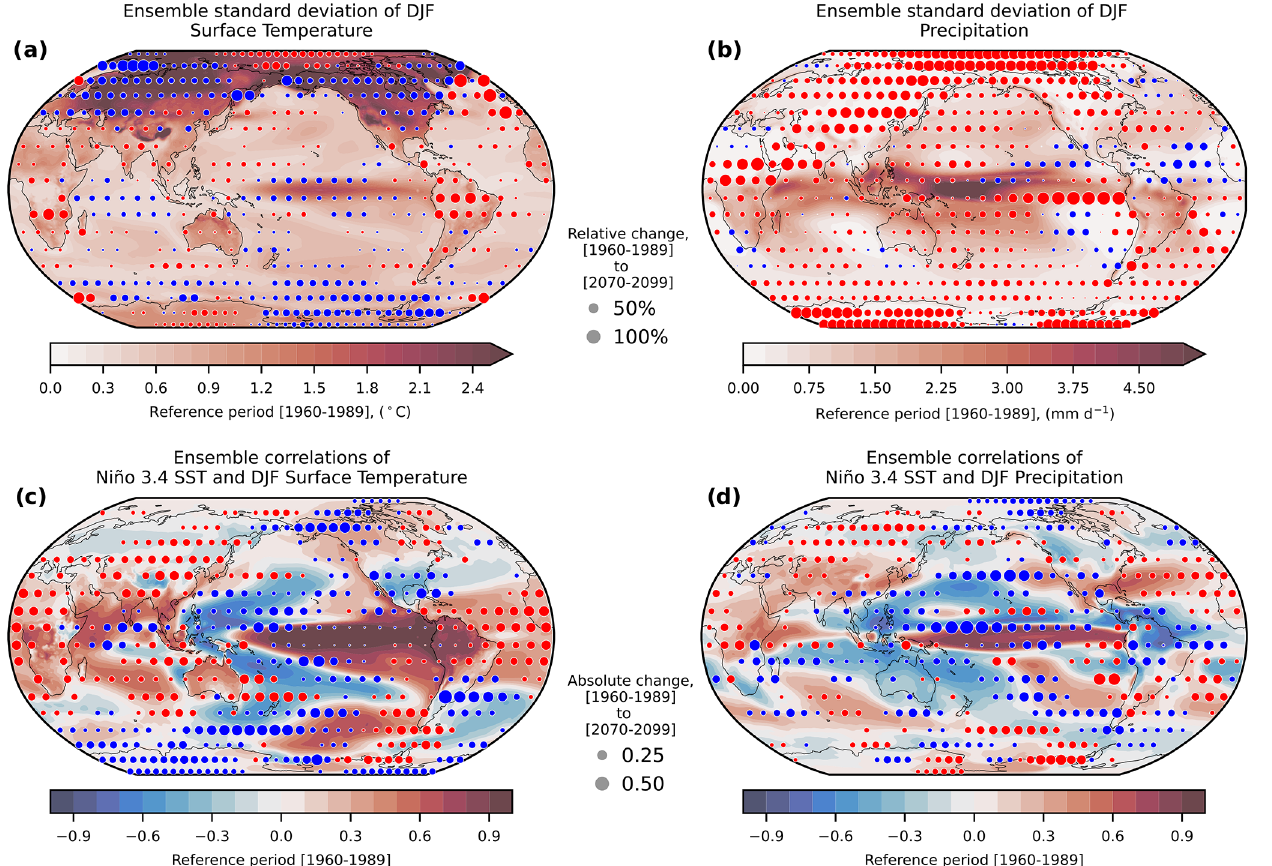
Figure 4. Changes in the patterns of interannual variability and Niño 3.4 correlation coefficients of December–January–February (DJF) surface temperature and precipitation. In the top row the color shading shows the time-averaged across-ensemble SD of the DJF seasonal mean surface temperature (a) and precipitation (b) for the period 1960–1989. Circles show the relative changes in the SD between 2070–2099 and 1960–1989, where insignificant change ( p ≥ 0 . 05) has been removed. Statistical significance of the changes (circles) was determined based on the p values of the two-sample Welch’s t tests for the equality of temporal means of the SDs, with the equivalent sample sizes adjusted to account for serial correlations (Sect. 3.3). In the bottom row the color shading shows ensemble-wise correlations of the Niño 3.4 index with surface temperature (c) and precipitation (d) anomalies for DJF, averaged over the period 1960–1989. Circles show the absolute change in correlations between 2070–2099 and 1960–1989, where statistically insignificant changes ( p ≥ 0 . 05) have been removed. The Niño 3.4 index for ENSO is the spatial average of sea surface temperature within 5 ◦ S–5 ◦ N, 170 ◦ –120 ◦ W. Statistical significance of the changes (circles) was determined based on the p values of two-sample Student’s t test of the Fisher z -transformed correlation coefficients (Timmermann et al., 2014). Note that the t test treats the ensemble standard deviations and correlations as stationary and serially uncorrelated within either of the two periods. For all four panels, the circles represent subsampled fields at 10 ◦ intervals over the global domain. The corresponding analysis for June–July–August (JJA) is presented in Fig.